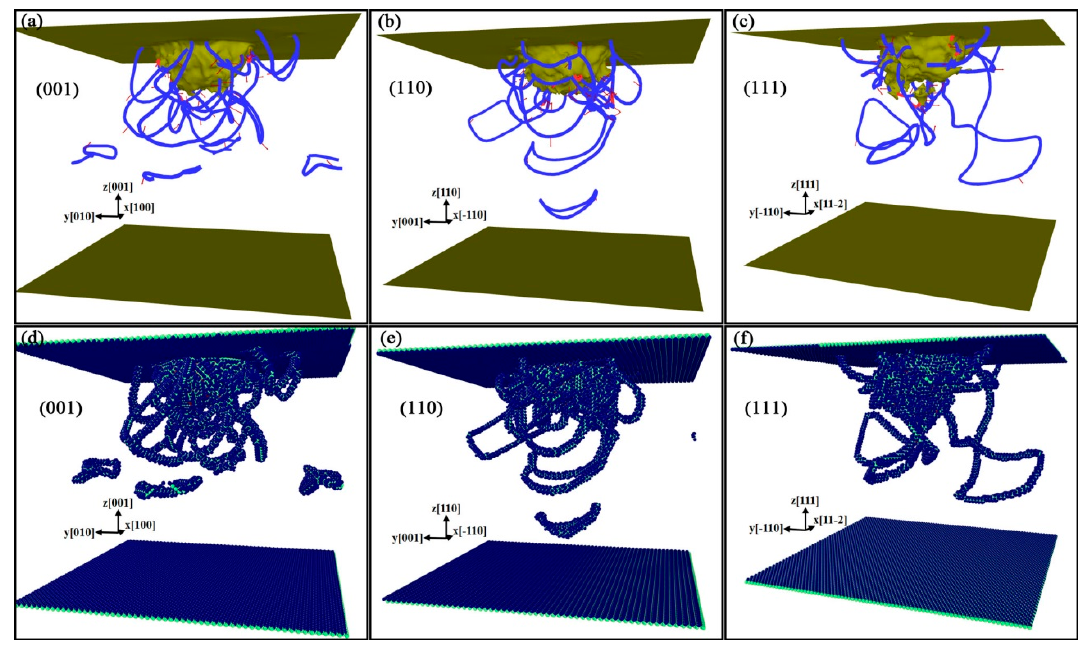
Figure 6. Dislocation distributions in GaN films indented on different planes at h = 35 Å. ( a – c ) DXA schematics in GaN films indented on (001), (110), and (111) planes, respectively, with dislocation lines indicated in blue, Burgers vectors by red arrows. ( d – f ) the corresponding IDS schematics.